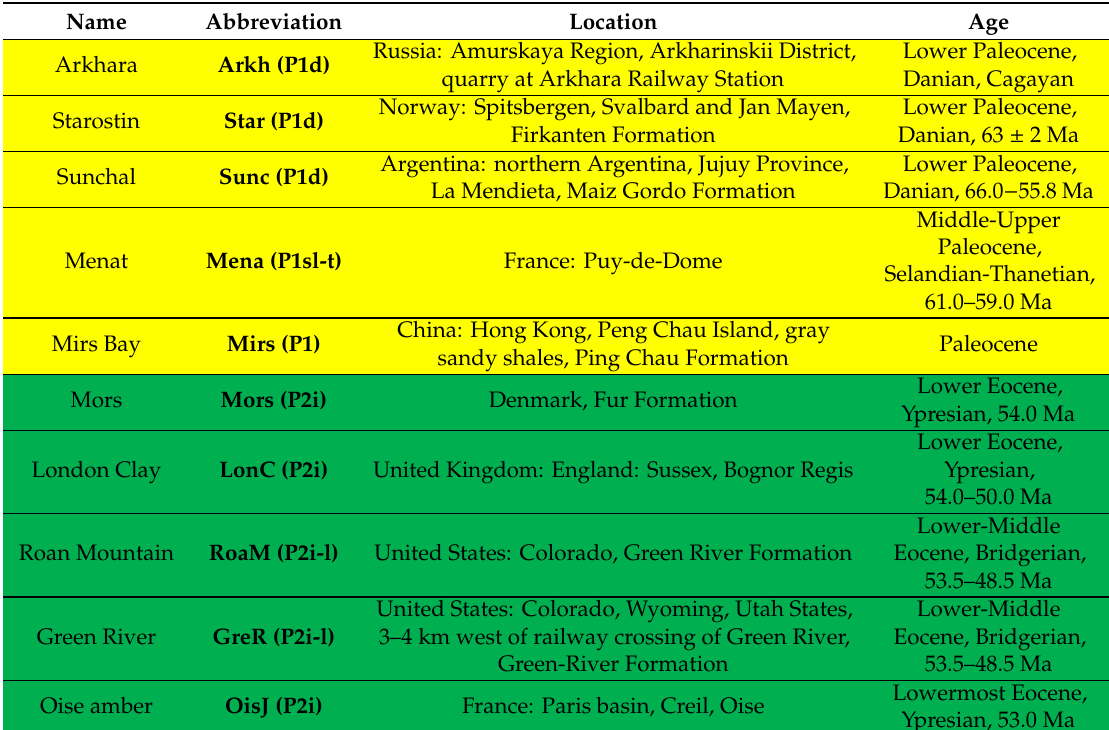
Figure 8. Composition of Curculionoidea species between Early Eocene localities.